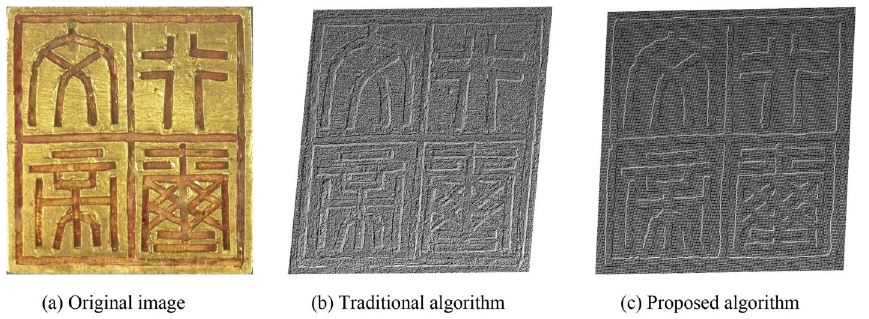
Figure 11. Point cloud comparison images of the “Wen Emperor seal”.